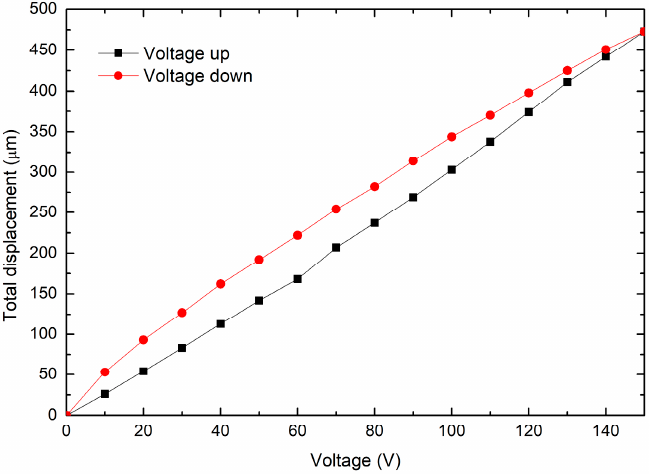
Figure 19. Total output displacement.